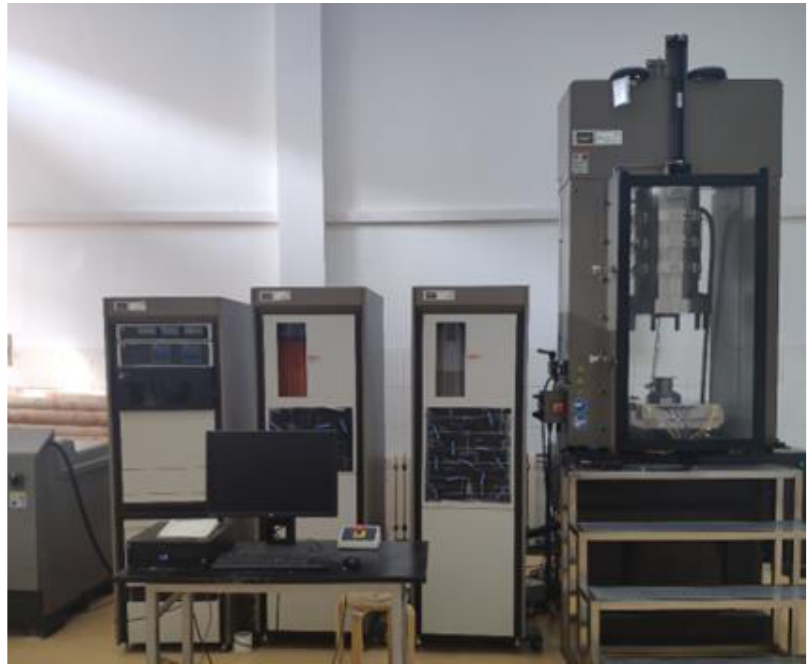
Figure 2. MTS815 all-digital hydraulic servo rock three-axis tester.